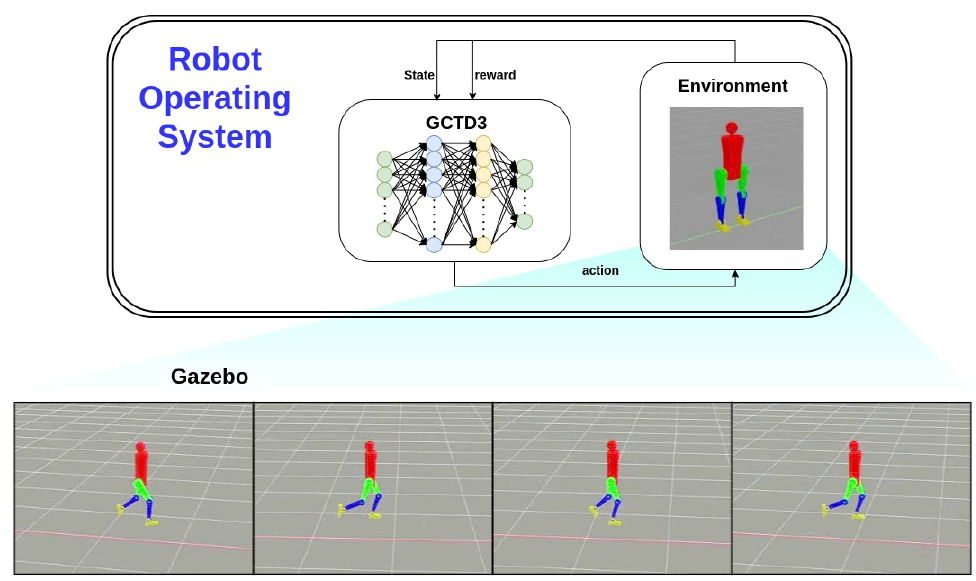
Figure 4. Diagram of the main components in the training and simulation process of the bipedal robot.